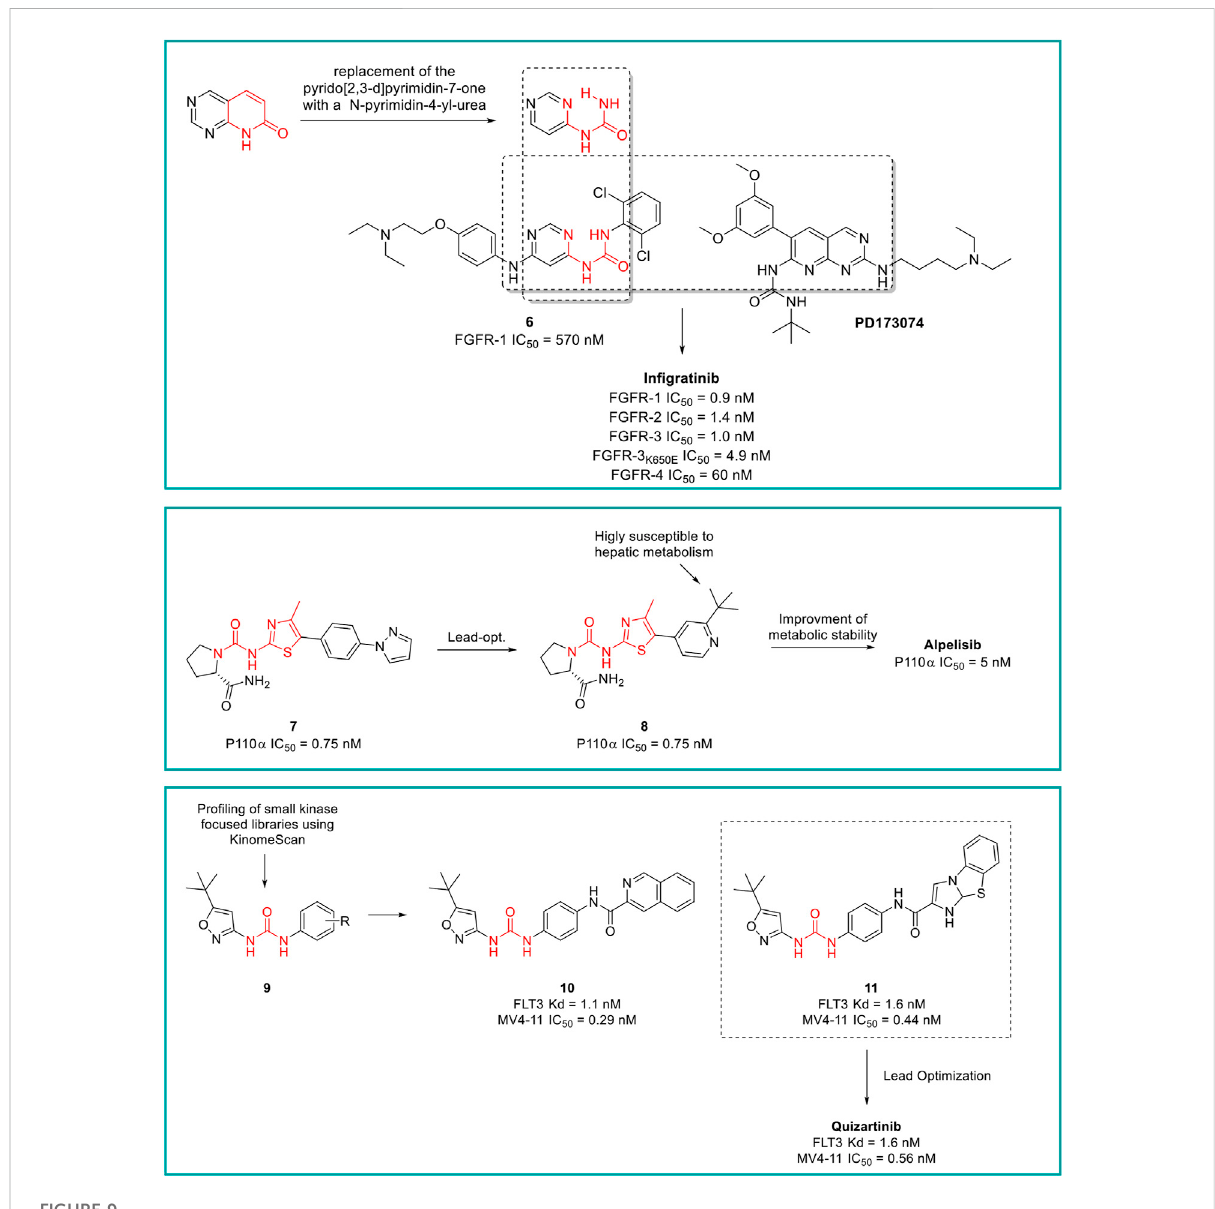
FIGURE 9 Key steps in the design of in fi gratinib, alpelisib and quizartinib.